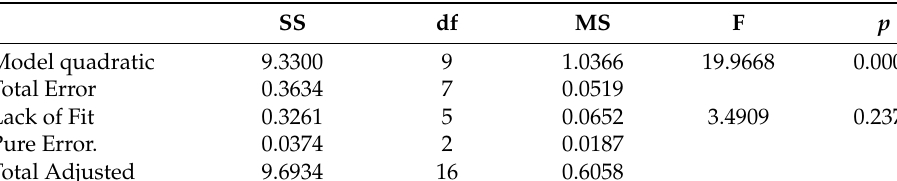
Table 4. Overall fit of quadratic Model Variances.